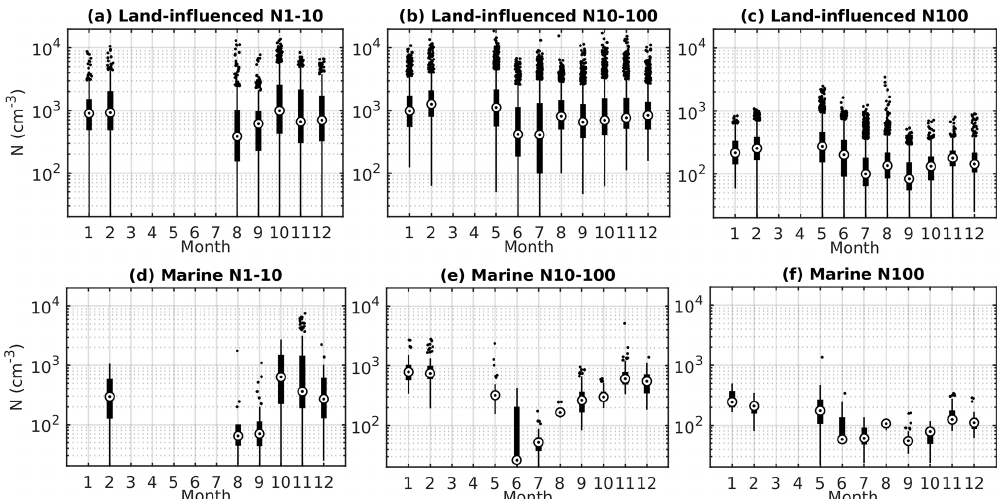
Figure 5. Seasonal cycles of particle number concentrations ( N ) in 1–10nm, 10–100nm, and above 100nm during land-influenced (a–c) and marine (d–f) land masses. The circles are the median concentrations for each month, black boxes mark the 25th and 75th percentiles, the whiskers mark 1.5 times the interquartile range, and the rest of the points are outside this